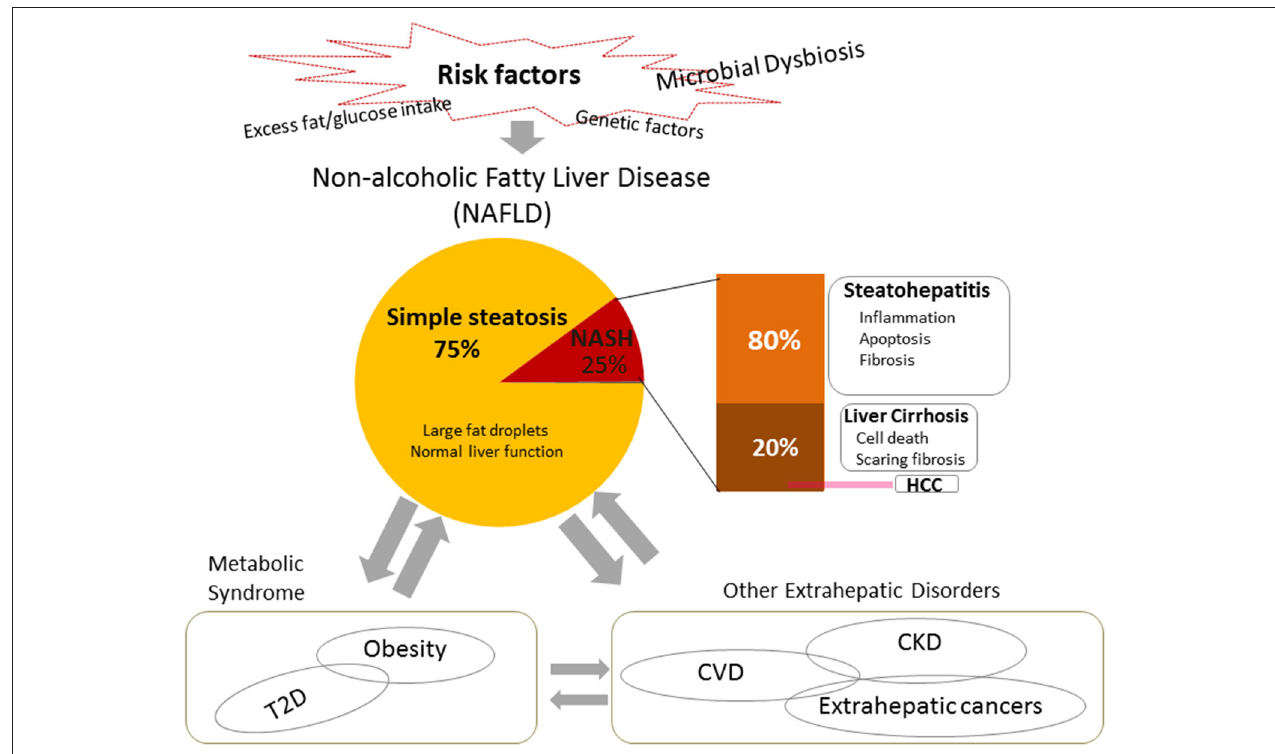
FIGURE 1 | Risk factors, pathogenesis, and systemic impacts of non-alcoholic fatty liver disease (NAFLD). NAFLD is the most common chronic liver disease worldwide, usually presenting as fatty hepatocytes (simple steatosis). Non-alcoholic steatohepatitis (NASH) is a severe type of NAFLD. It is usually characterized by inflammation, cell damage, and apoptosis, and may include fibrosis. In turn, it can progress to cirrhosis or end-stage liver disease, i.e., hepatocellular carcinoma (HCC). In addition to heredity, one of the most widely accepted risk factors for NAFLD is excessive fat/glucose intake. Recent studies indicate that microbial dysbiosis takes an important role in the pathogenesis and the development of NAFLD. NAFLD leads not only to the development of hepatic diseases, but also connects with and contributes to systemic diseases, such as metabolic syndrome and extrahepatic disorders. NASH, non-alcoholic steatohepatitis; HCC, hepatocellular carcinoma; CDVs, cardiovascular diseases; CKD, chronic kidney disease, T2D, type 2